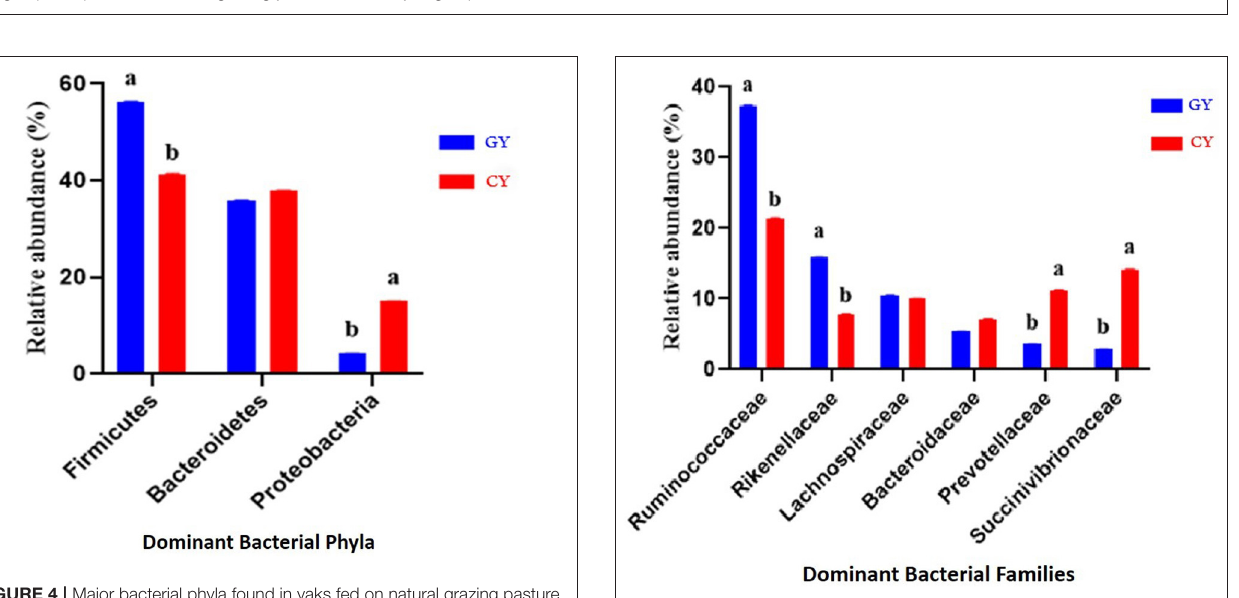
FIGURE 3 | Unweighted pair group method with arithmetic mean (UPGMA) based on the weighted uniFrac distance was used for the clustering analysis of GY and FY group samples. GY, Pasture grazing yaks; FY, feedlot yak group.